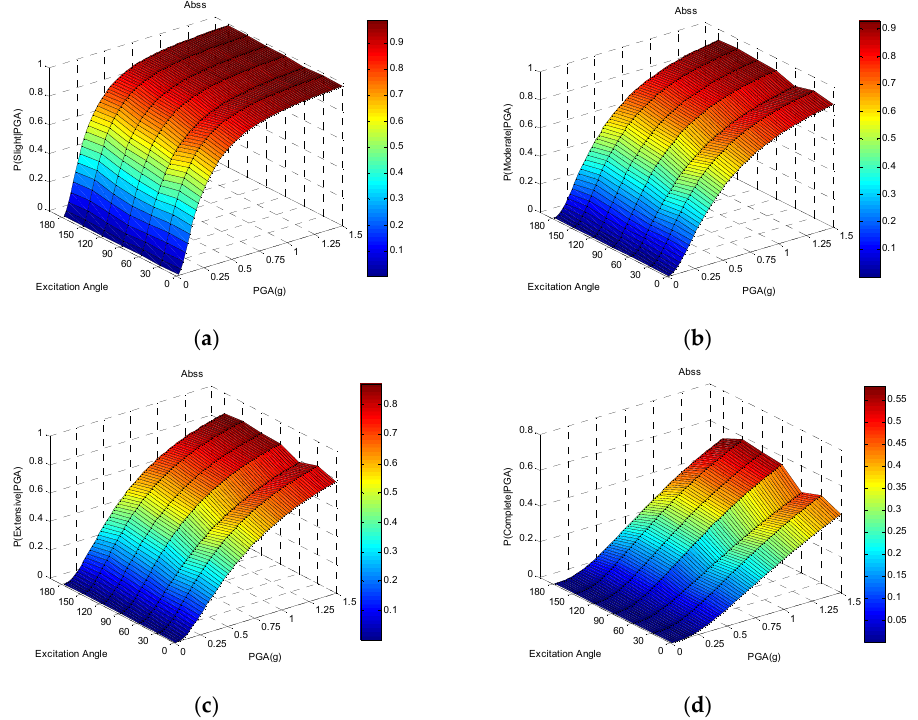
Figure A6. Seismic fragility surfaces of Abss subjected to different excitation angles in the ( a ) slight; ( b ) moderate; ( c ) extensive; and ( d ) complete limit states.